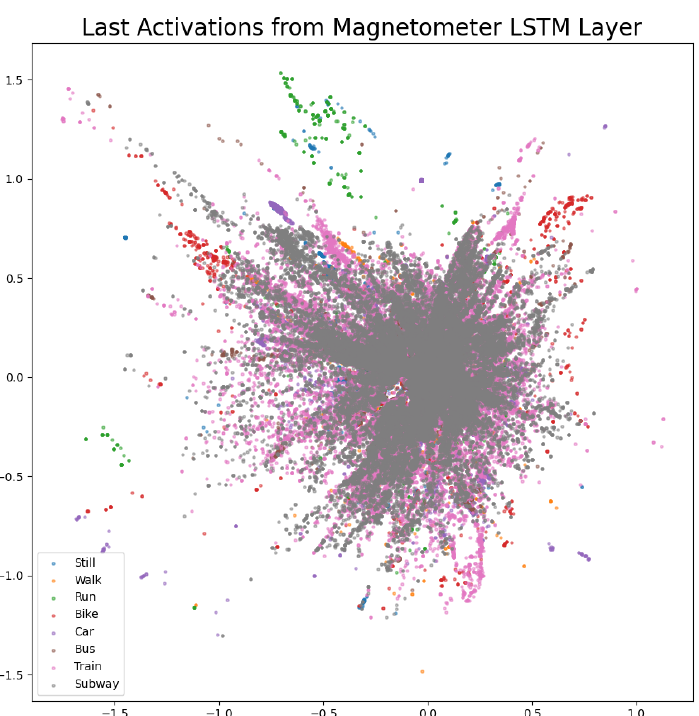
Figure 13. The 2D encoded representation of the last activations of the LSTM layer for the magne- tometer. Color codes: blue (still), orange (walk), green (run), red (bike), violet (car), brown, (bus), pink (train), grey (subway).